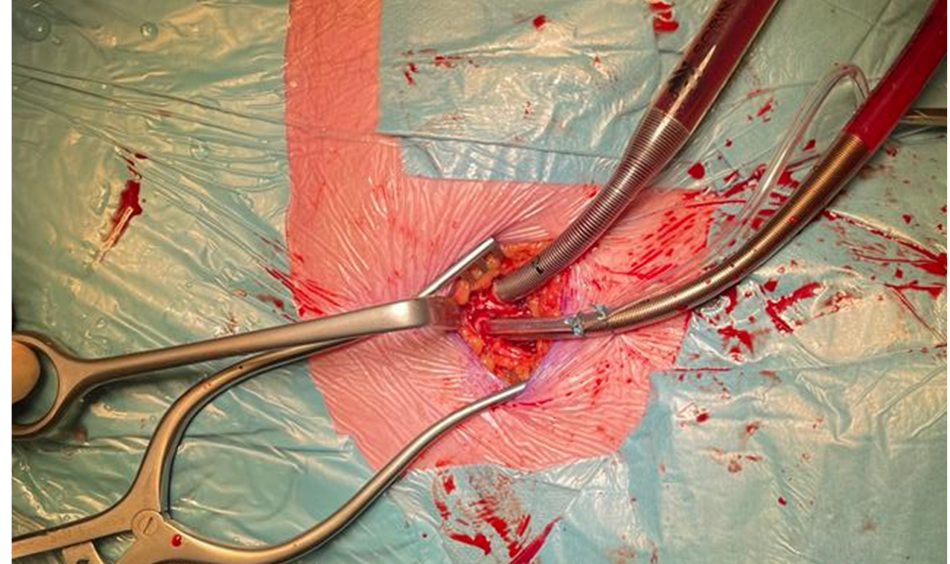
Figure 4. Peripheral arterial and venous cannulation in the right groin. Standard arterial cannula for direct aortic cross clamp technique. When using an endoaortic balloon, there is a sidearm in the arterial cannula to insert the balloon.